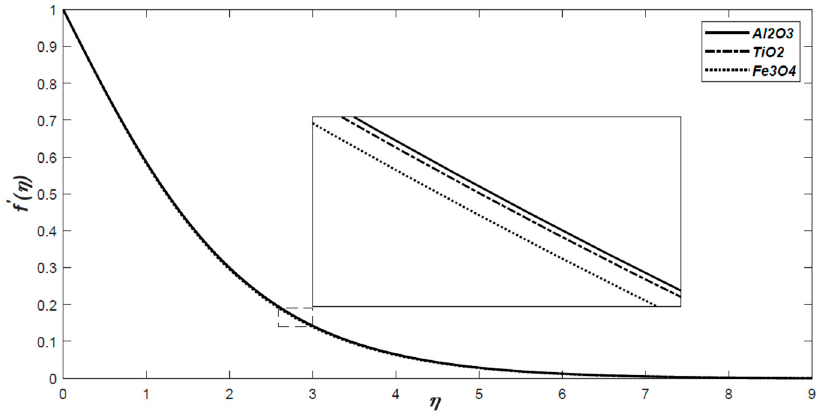
Figure 1. The dimensionless velocity profiles for volume fraction 𝜙 = 0.02 for all three nanofluids with respect to similarity variable 𝜂 .